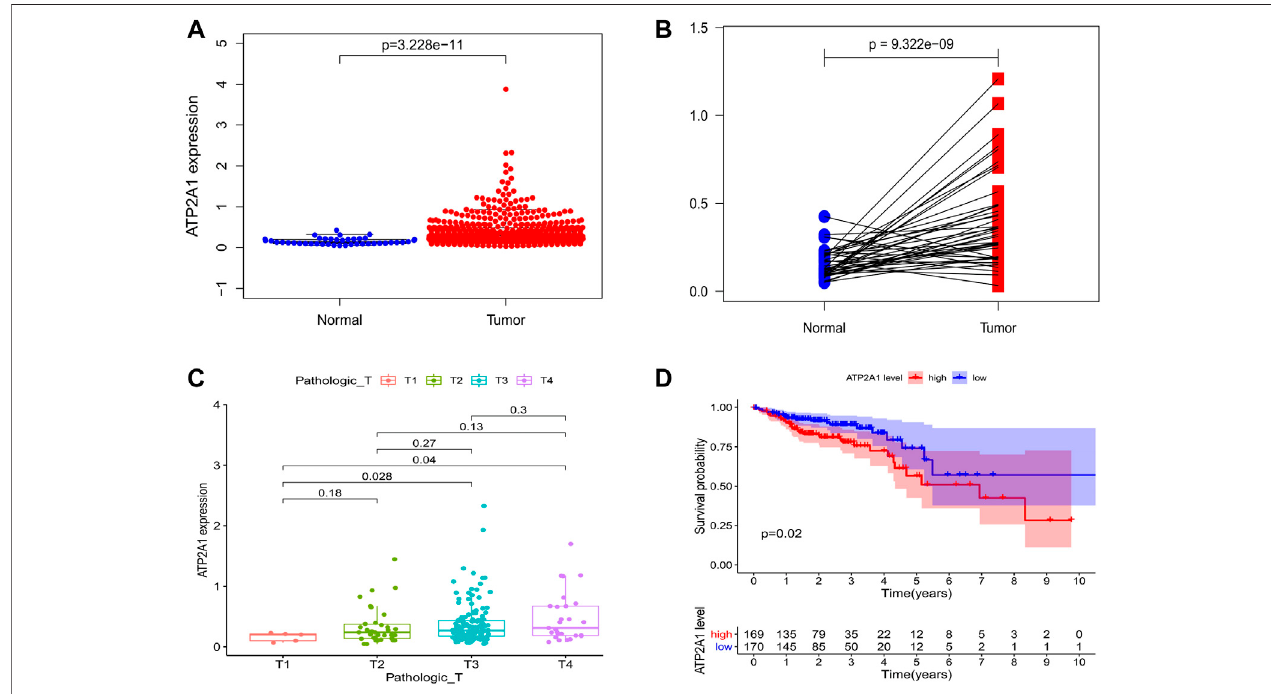
FIGURE 1 | Bioinformatics analysis of ATP2A1 expression and survival in colorectal cancer patients. (A) The expression of ATP2A1 in paracancerous tissues was lowerthanthatintumortissuesinTCGAdataset( p =3.228e-11). (B) Pairedanalysisof ATP2A1 expressionofcolorectalpatientsinTCGAdatabase( p =9.322e-09). (C) Correlations of ATP2A1 expression with Pathologic T (T3 vs. T1, p = 0.028; T4 vs. T1, p = 0.04). (D) KM survival analysis of ATP2A1 high expression group and low expression group ( p = 0.02).